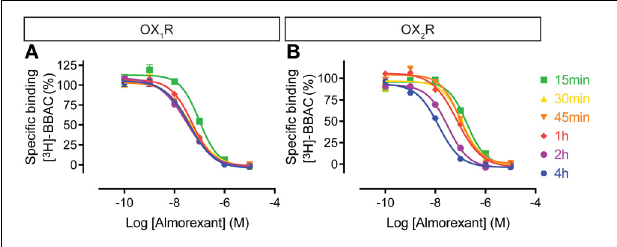
FIGURE 4 | Effect of time on almorexant competition for [ 3 H]-BBAC ((S)-N-([1,1 (cid:2) -biphenyl]-2-yl)-1-(2-((1-methyl-1H-benzo[d]imidazol-2- yl)thio)acetyl)pyrrolidine-2-carboxamide) binding to membranes from CHO cells expressing human (A) OX 1 R or (B) OX 2 R. Data is representative of triplicate determinations and error bars indicate s.e.m.